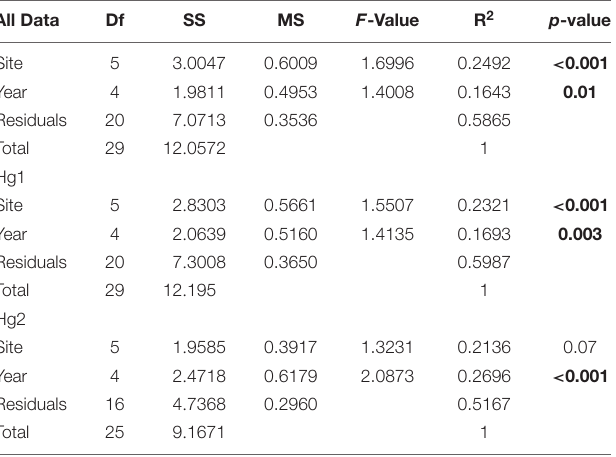
TABLE 3 | Permutation-based multivariate analysis of variance in Pyura chilensis to determine the percentage of variance explained by the effects of sampling sites and year of sampling.